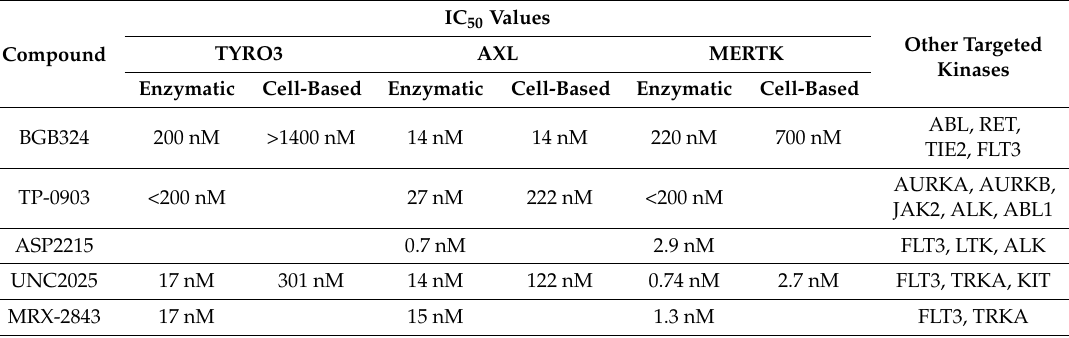
Table 1. TAM receptor small molecule inhibitors in